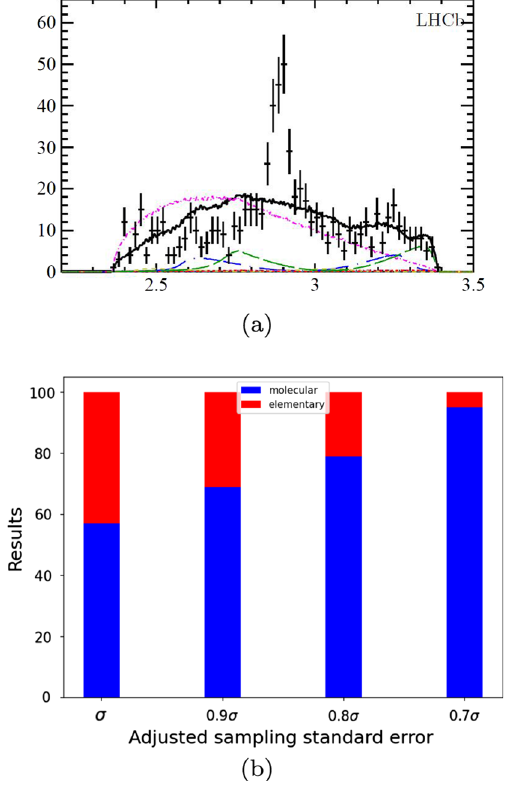
Fig. 7 a Experimental data of X 1 ( 2900 ) [38]. b Outputs of X 1 ( 2900 ) . Where the σ stands for the experimental error bar